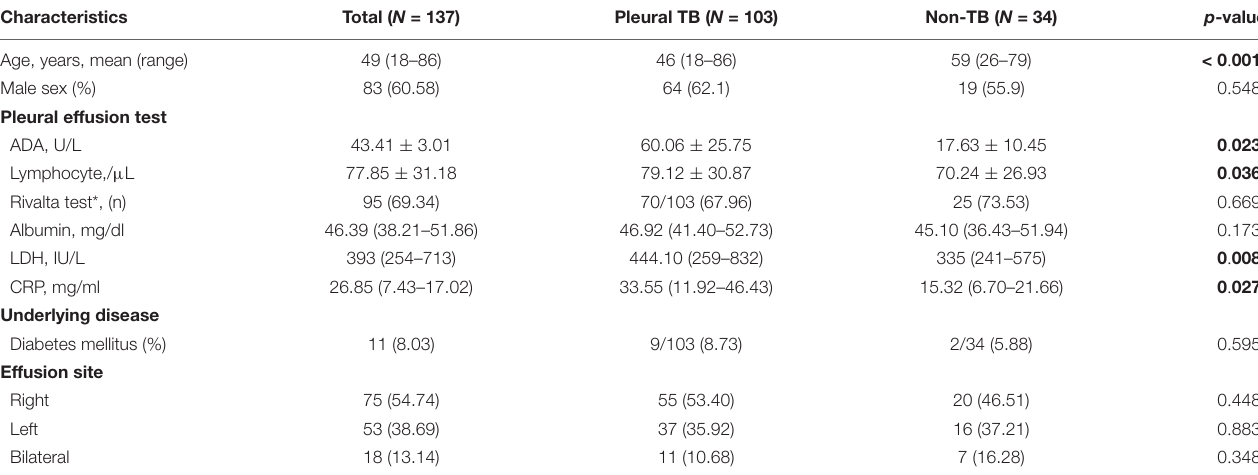
TABLE 1 | Clinical characteristics in the study